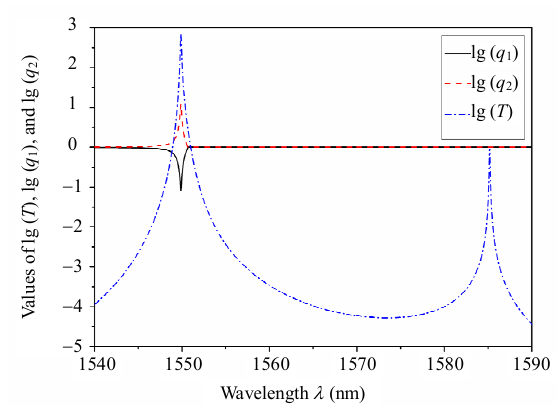
Fig. 4 Transmission spectrum and two eigen values of the scatter matrix with 